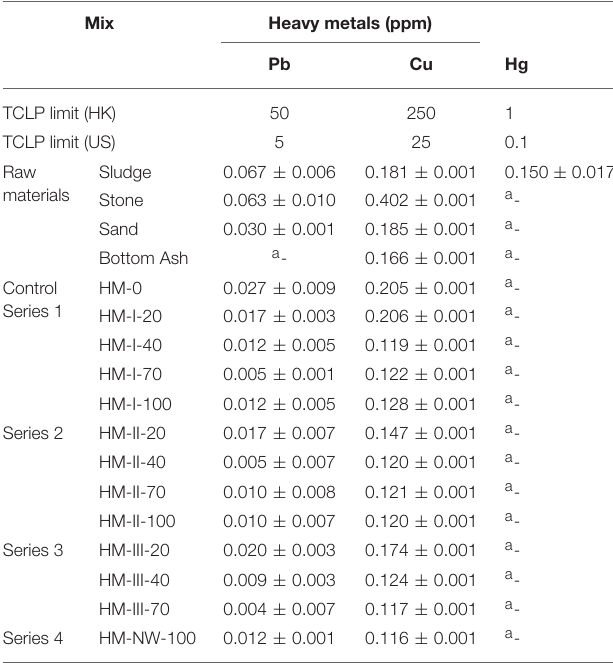
a Below limit of detection = 0.001